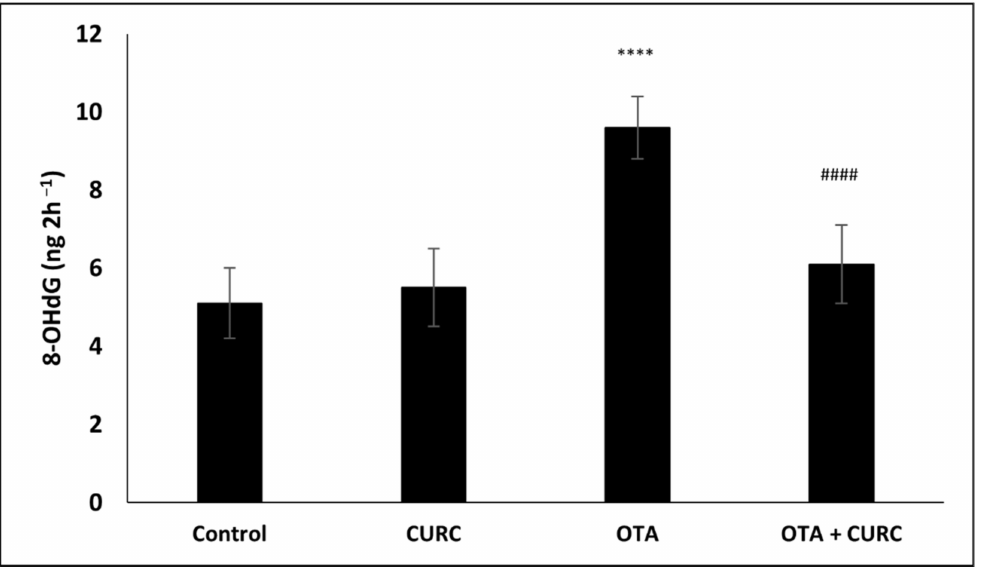
Figure 8. Effect of curcumin (CURC) on urinary 8-OHdG concentration at the end of treatment. Control group; CURC group (100 mg/kg b.w. of CURC); OTA group (0.5 mg/kg b.w. of OTA); OTA + CURC group (0.5 mg/kg b.w. of OTA plus 100 mg/kg b.w. of CURC). Data are shown as mean ± standard deviation (DS) ( n = 6 for each group) and were compared by ANOVA (**** p <0.0001 vs. control, #### p < 0.0001 vs.